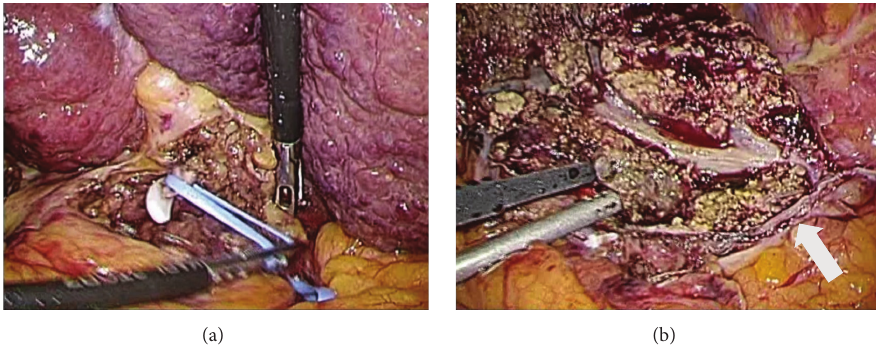
Figure 3: (a) The left branch of the portal vein was temporarily clamped so as to clarify a demarcation line. (b) The left hepatic vein was divided by an endoscopic linear stapler (arrow), and a cut surface along the middle hepatic vein was revealed.